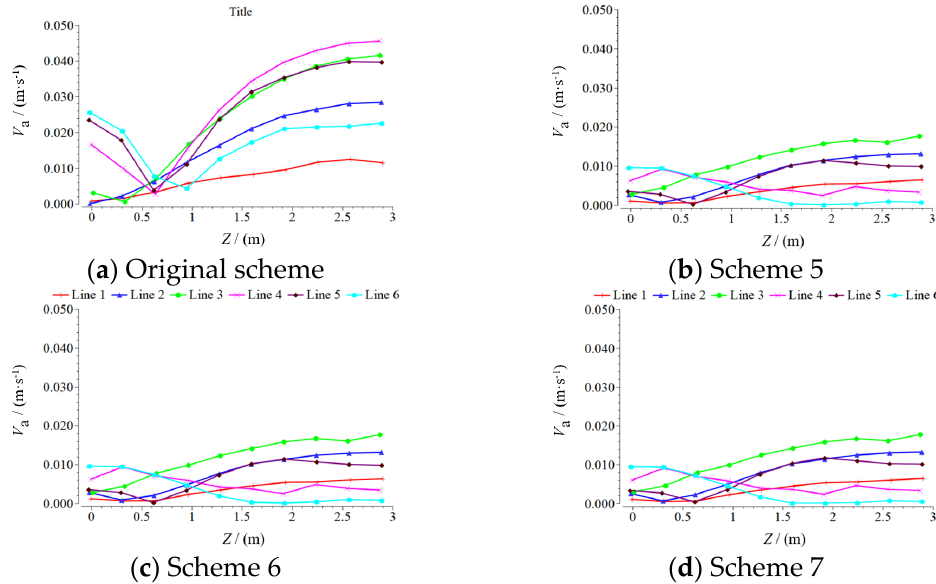
Figure 13. Diagram of axial velocity on the inlet of the sump 1#.